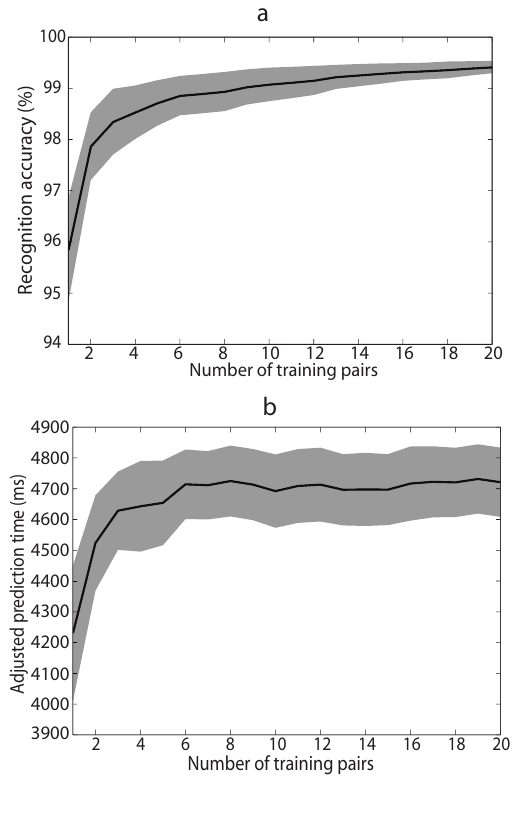
Figure 7. Average recognition accuracy ( a ) and adjusted prediction time ( b ) over seven able-bodied subjects with the number of training pairs ranging from 1 to 20 . Color shades denote SEMs across